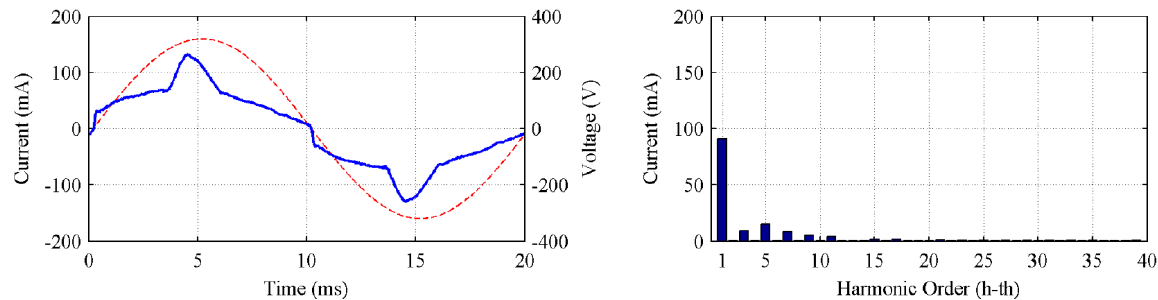
Figure 11. CFL-A: Current waveform and its harmonic spectrum.